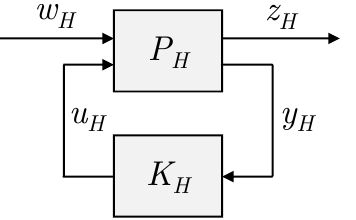
Figure 3. Lower linear fractional transformation diagram for the H ∞